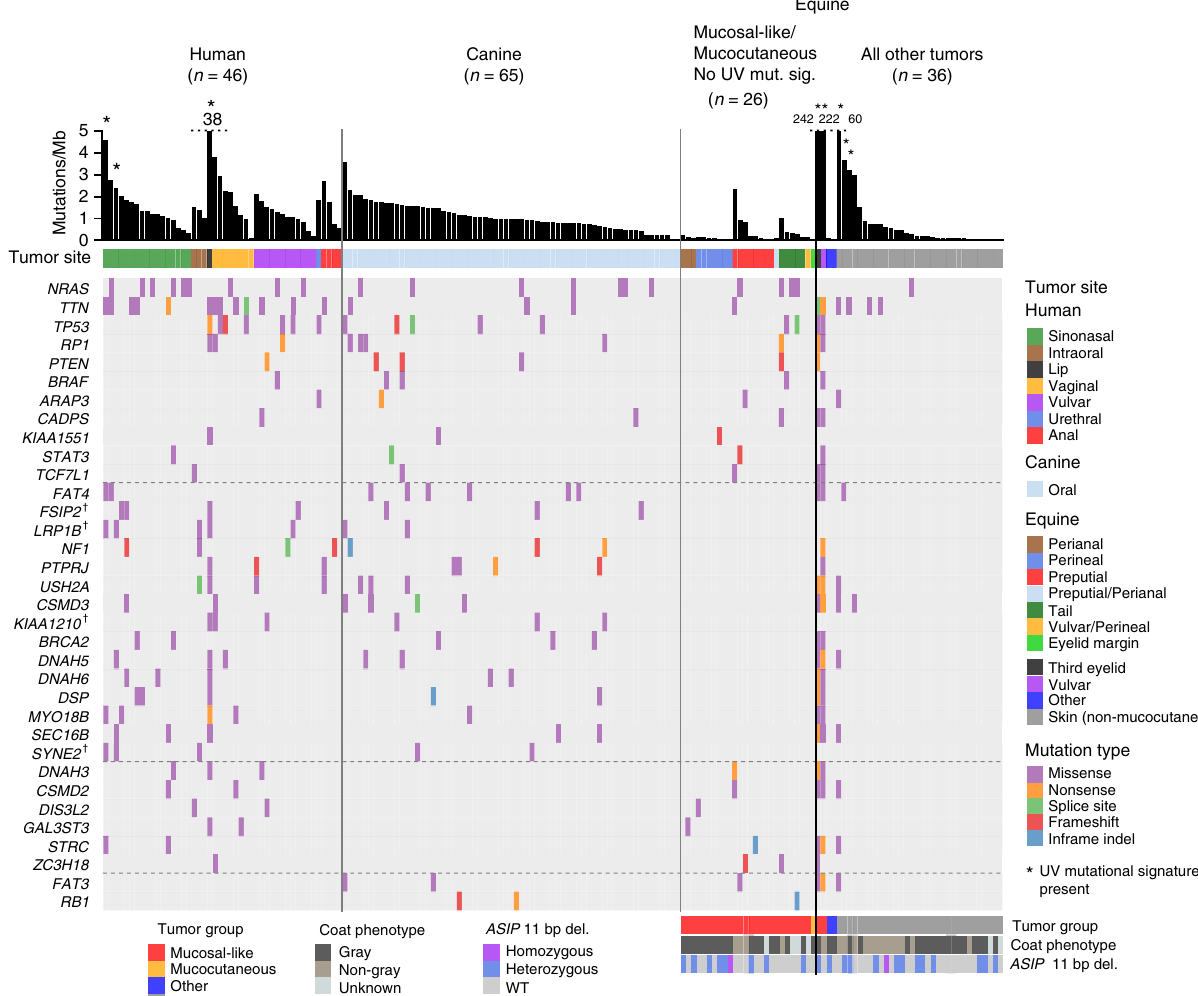
Fig. 2 Comparative mutational landscape of primary melanomas from human, canine, and equine patients. Shown are the most frequently mutated genes in at least 2 of the 3 species. For genes commonly mutated in human and canine samples only, genes displayed were mutated in at least 5 samples in total, and in at least 3 samples in all other comparisons. When counting mutations and genes, we excluded two equine samples from mucosal-like sites with a high mutation rate and a UV mutation signature, and samples not classi fi ed as originating from mucocutaneous or mucosal-like sites; these samples, indicated as “ All other tumors ” , are shown for comparative purposes. Details of tumor site and type are the same as described in Fig. 1. Dagger, The gene has not been annotated in the equine genome in Ensembl release